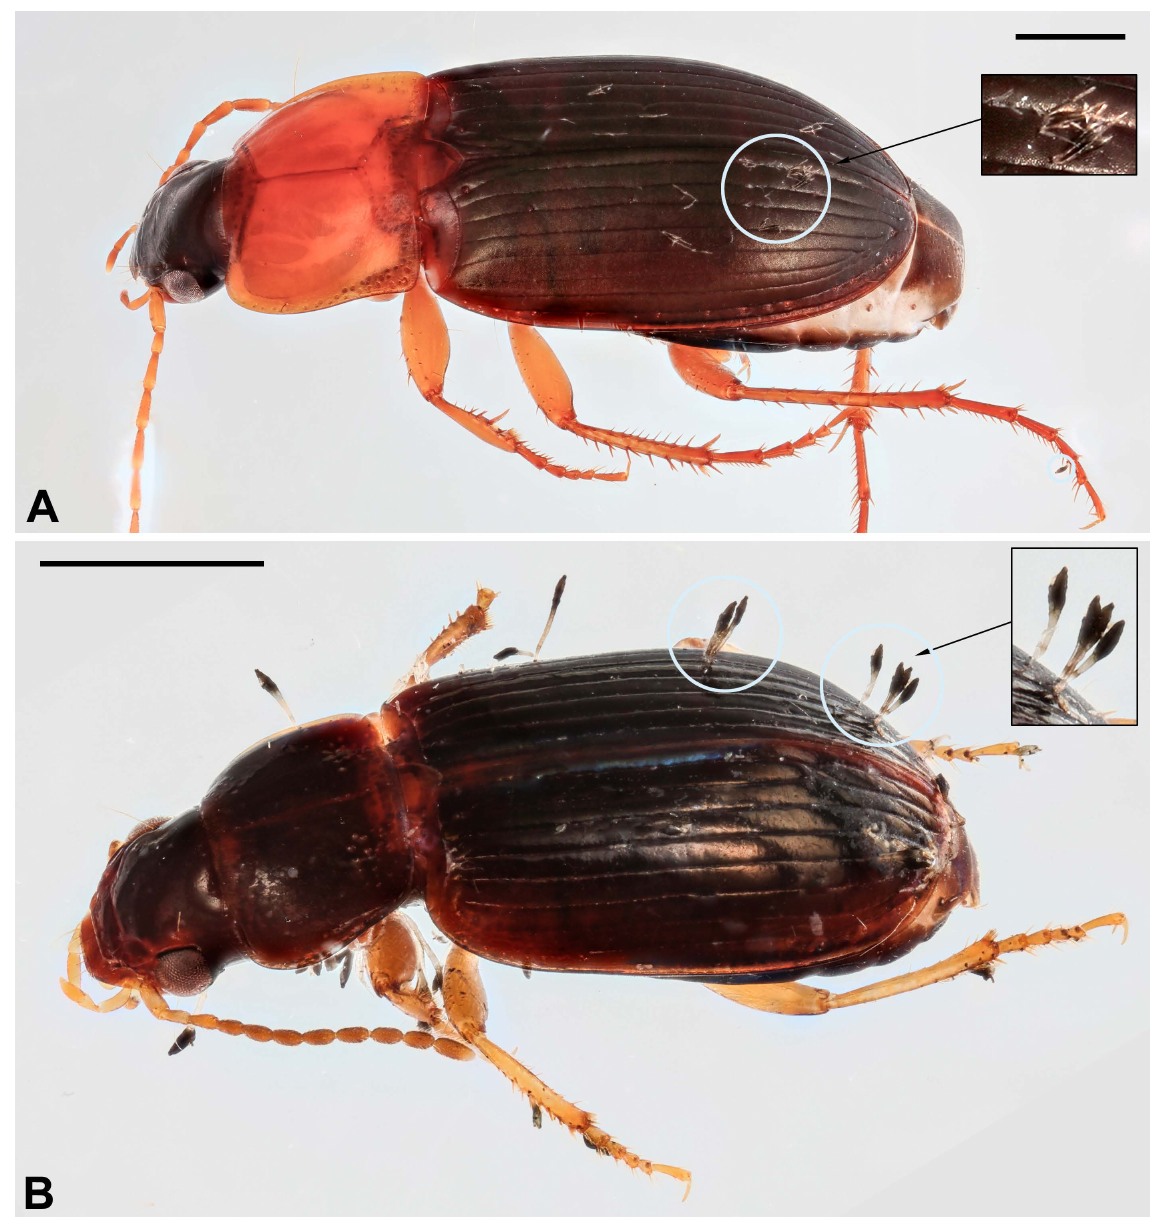
Fig. 104. Habitus of hosts with fungi. Some thalli are zoomed in, and others are encircled. A . Calathus melanocephalus with mature and immature thalli of Laboulbenia calathi on dorsal side of the elytra. B . Bradycellus csikii with thalli of Laboulbenia eubradycelli on various parts of the body. Scale bars: 1 mm. (Photos: Aslak Kappel